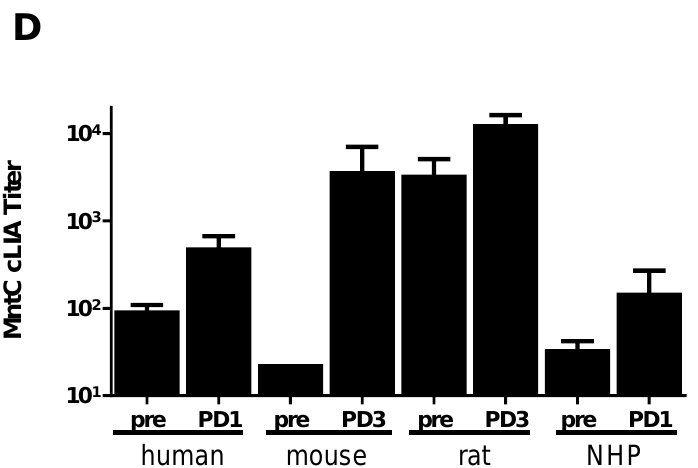
Figure 1. SA4Ag antigens are immunogenic in preclinical species. Immune responses against SA4Ag antigens CP5, CP8, ClfA, and MntC were measured before (pre) and after (PD) immunization. Rodents were immunized three times subcutaneously with SA4Ag + AlPO 4 prior to sample collection post-dose 3 (PD3). Non-human primates (NHP) were immunized a single time with SA4Ag without adjuvant. Anti-capsular immune responses were measured by the OPA assay for CP5 ( A ) and CP8 ( B ). Anti-protein immune responses were measured by cLIA for ClfA ( C ) and MntC ( D ). Human responses to a single unadjuvanted dose of SA4Ag are included as a comparator, adapted from [27].